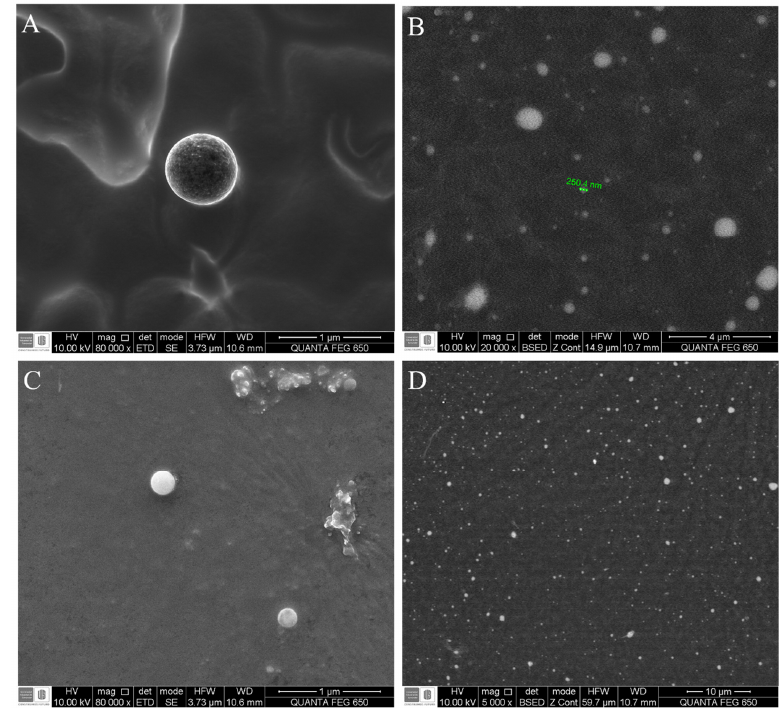
Figure 2. Micrograph of the G19NP and G17NP obtained by scanning electron microscopy (SEM). ( A ) Morphology of the G17NP; ( B ) General shape of the G19NP population; ( C ) Morphology of the G19NP; ( D ) General shape of the G19NP population.